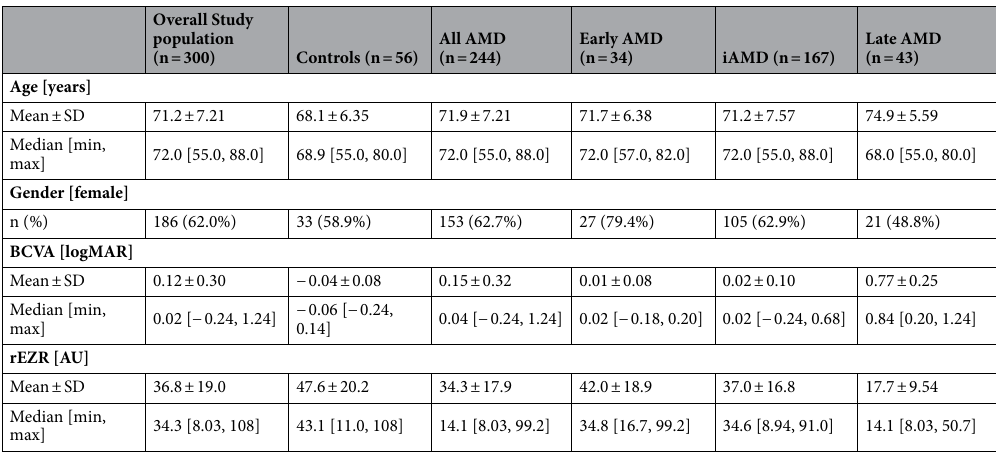
Table 1. Characteristics at baseline for the study population eligible for rEZR determination (controls and AMD subjects), for only controls, for all AMD subjects and for each of the AMD subgroups. AMD age-related macular degeneration, iAMD intermediate AMD, AU arbitrary units, BVCA best-corrected visual acuity, SD standard deviation, rEZR relative ellipsoid zone